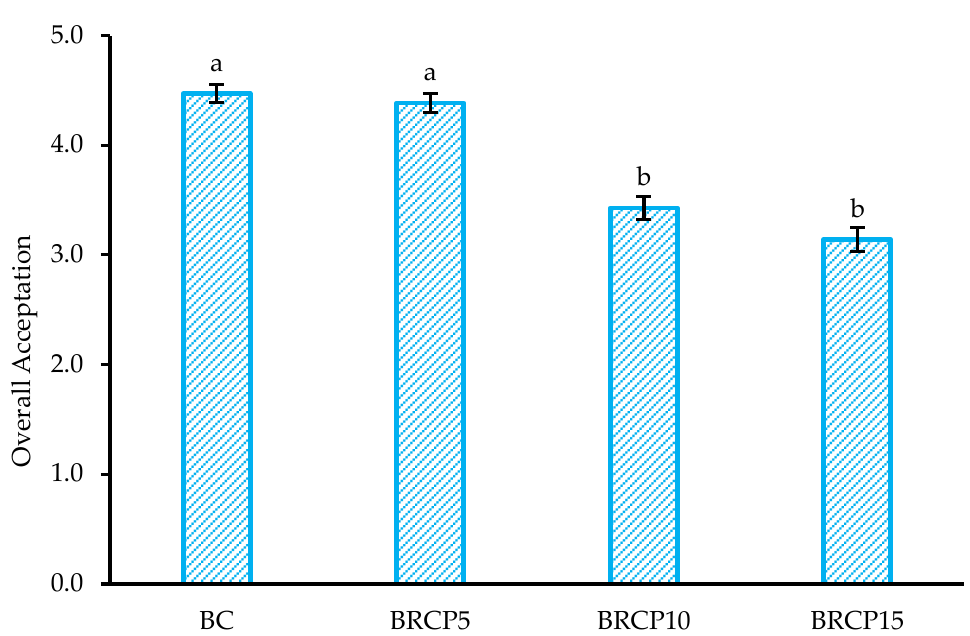
Figure 3. Sensory acceptance of biscuits enriched with roselle calyx powder. Results are presented as means ± SE ( n = 70) on a dry weight basis. Values followed by the different letters in the same line are significantly different in Tukey’s test ( p < 0.05). BC = biscuit control; BRCP5 = Biscuit enriched with 5% roselle calyx powder; BRCP10 = Biscuit enriched with 10% roselle calyx powder; BRCP15 = Biscuit enriched with 15% roselle calyx powder.